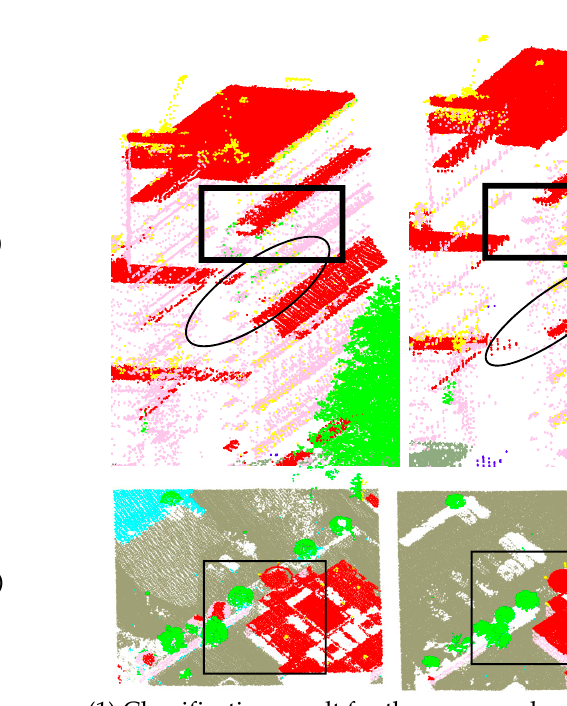
Figure 16. Errors due to our change detection algorithm. Colors in this figure represent the same objects as in Figure 15. In Figure 16, group (1 a ) shows some errors in the ellipse that are due to scene classification errors, and some in the box are due to lack of the contextual information (wall points far away from the roof). Group (1 b ) shows unknown points labelled as unchanged. As seen in the classification result of Group (1b, left-hand), there is a lack of data (some holes) due to limited reflection (red) in the left-hand image of the roof, but the roof in the right-hand image is quite well covered. We expected the entire area where data is lacking to be labelled “unknown”, but in the result in (2) only the central parts of the “gaps” are “unknown” (light blue), while other parts are labelled “unchanged” (brown).